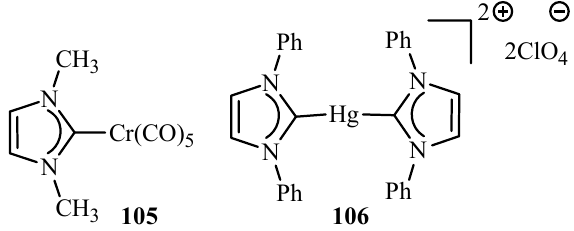
Figure 10. Metal complexes reviewed by Herrmann et al. [22].